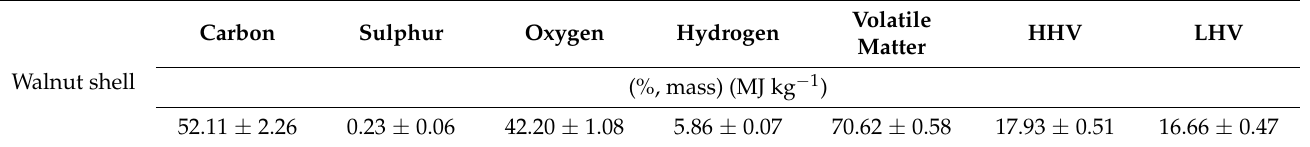
Table 2. Combustible matter content in the walnut shell.